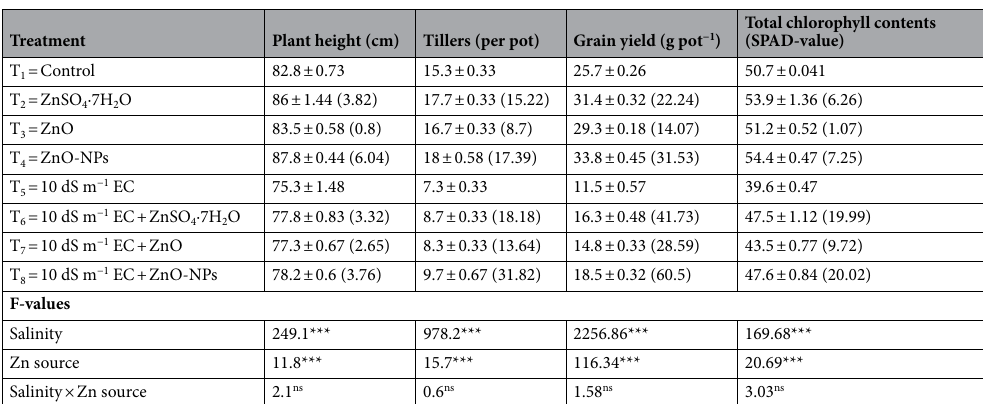
Treatment Plant height (cm) Tillers (per